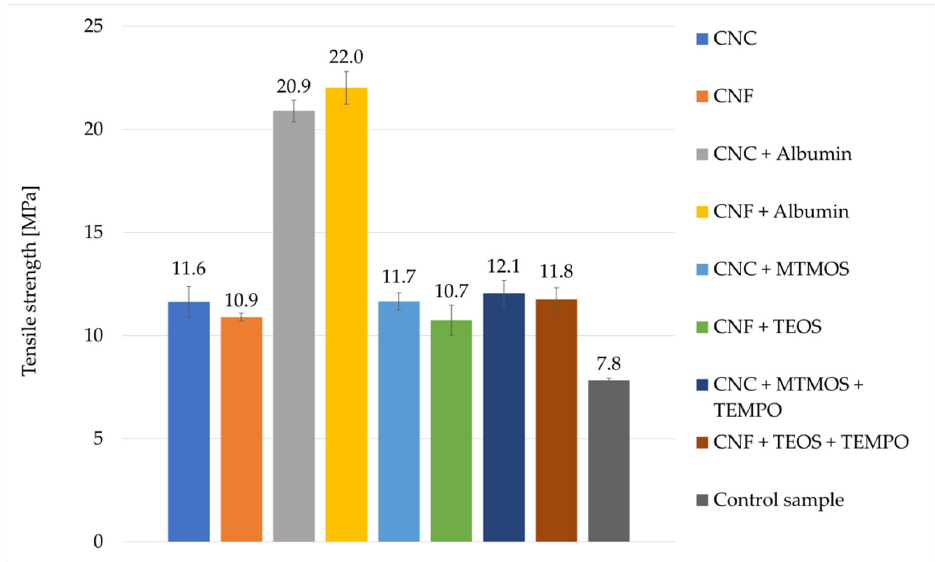
Figure 8. Tensile strength (MPa) of samples. Table 2. Statistical parameters of the tensile strength (MPa) of samples.